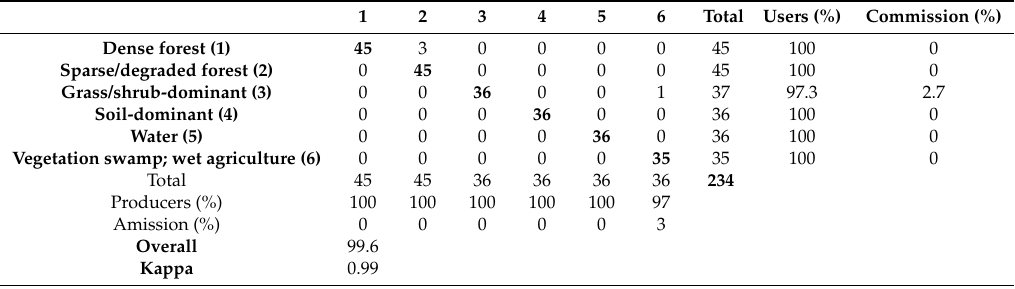
Table A7. LandSat Accuracy Classification. Confusion Matrix Produced for Classification of August 2014 Landsat Data using Independent Validation